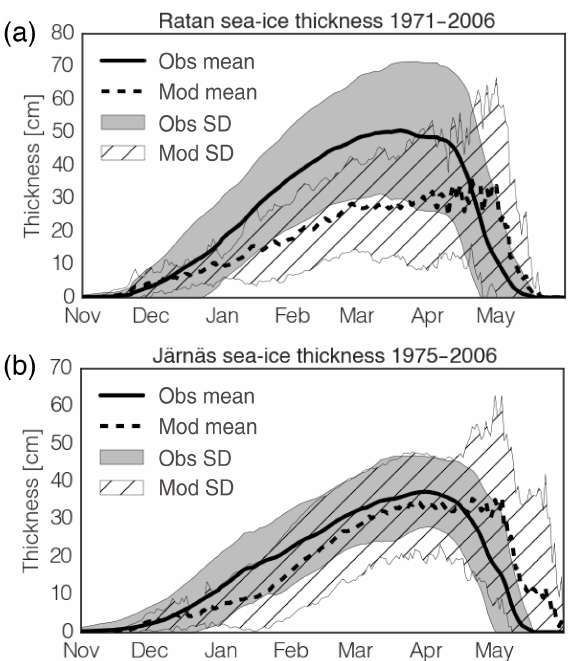
Figure 14. Seasonal simulated and observed sea-ice thickness at coastal sites (a) Ratan and (b) Järnäs. The lines show the seasonal daily means and the filled envelopes show the ± 1 standard devia- tions. The seasonal cycles are calculated for the periods 1971/1972– 2005/2006 and 1975/1976–2005/2006 for the Ratan and Järnäs sites, respectively. For the locations of the sites, see Fig.